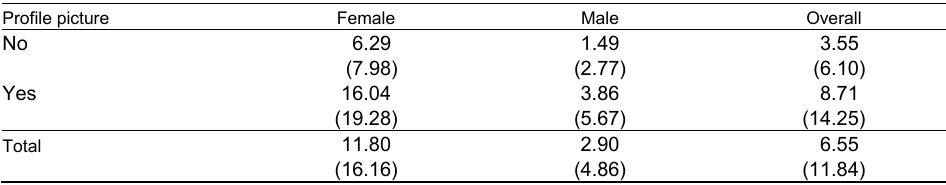
Ingoing first contacts of online users depending on whether or not their profile contained a picture (means with standard deviations in parentheses)